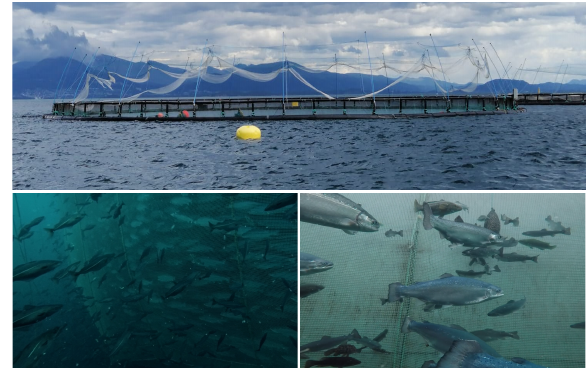
Figure 7: Fish farm where video footage for the ex- periments was collected. View of a salmon cage on the surface (top), wild fish outside the net pens (bottom-left), salmon inside the net pens (bottom-right)